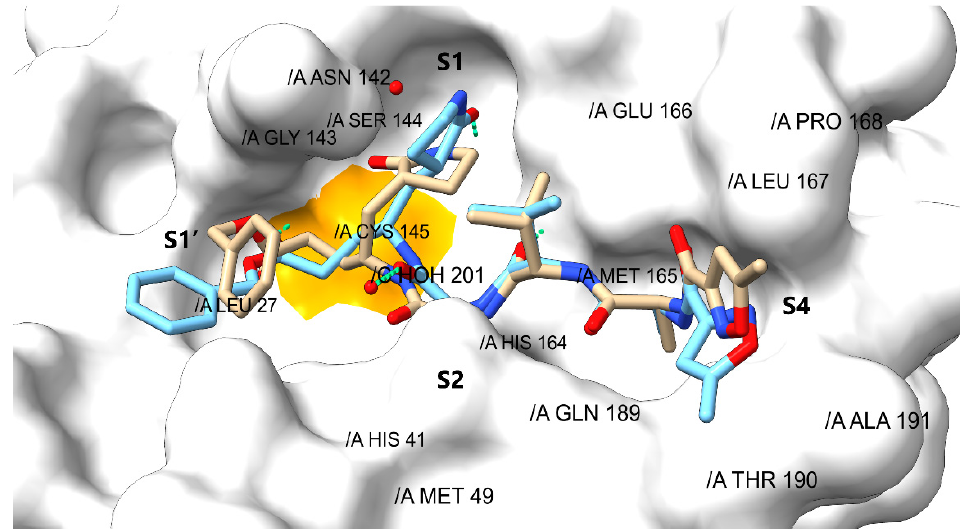
Figure 4. N3 redocking over SARS-CoV-2 M pro (PDB ID: 7BQY). The co-crystallized inhibitor is shown in blue, the MOE-docked inhibitor in brown (RMSD = 0.65), and orange highlights the covalent interaction with Cys145.